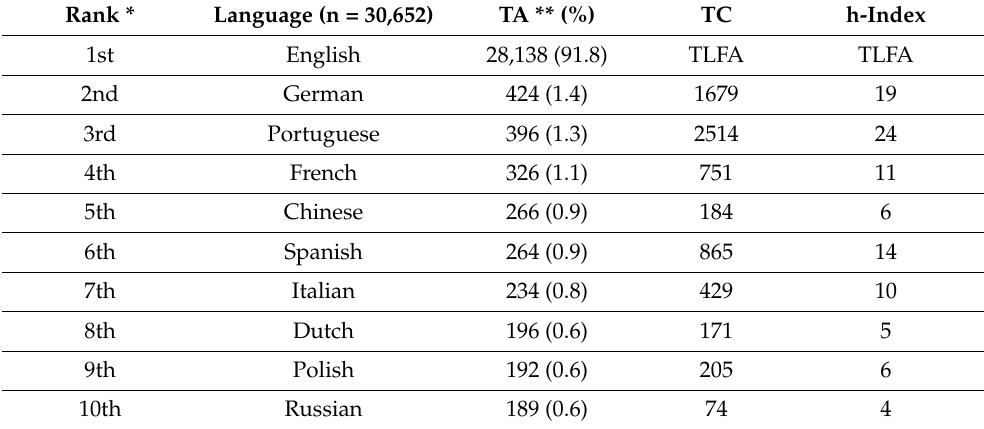
Table 4. Top ten languages in which articles concerning dentists were published.